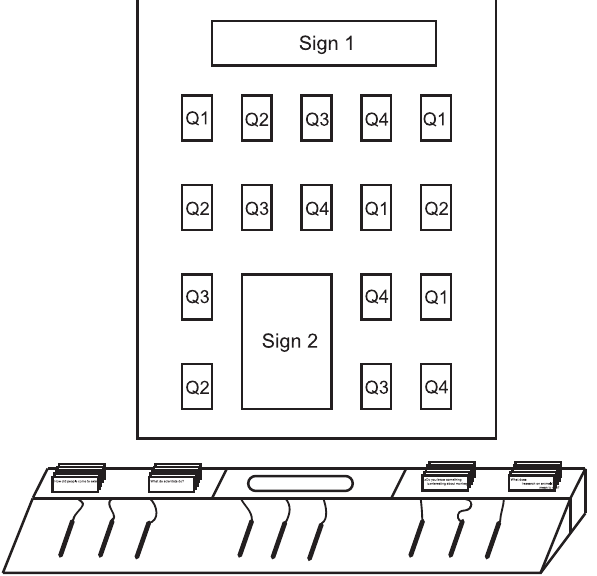
Figure 2. Schematic illustration of the drawing board and secured display panel. Q1 to Q4 refers to the questions described in the main text. Sign 1 reads: ‘‘Share your ideas! For people of all ages’’. Sign 2 reads: ‘‘Win a Prize! Share your ideas… Just complete a card! Don’t forget your age and email so we can tell you if you win! Prizes for adults (over 16) Prizes for children (below 16) Post your card here [arrow pointing towards the posting slot]’’.